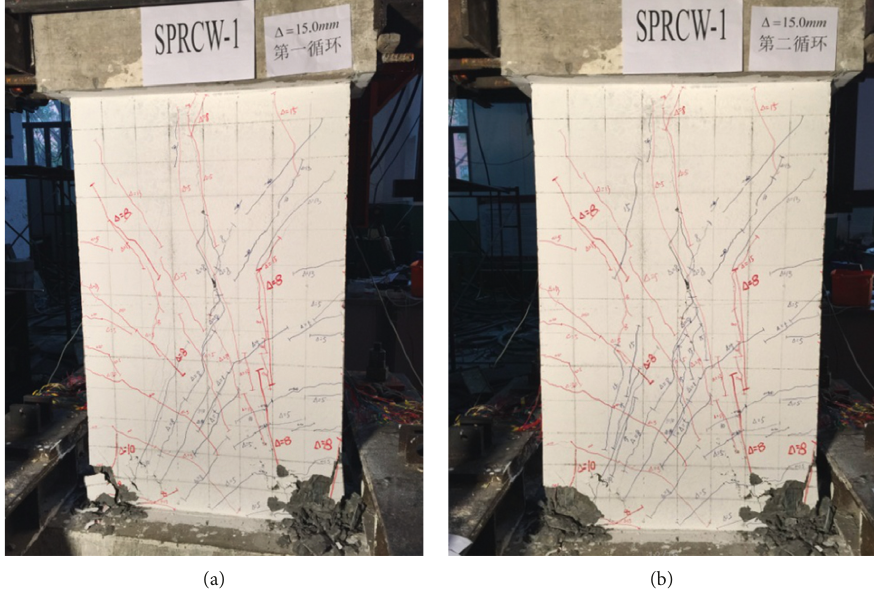
Figure 8: Diagram of cracks in the Δ � 15mm displacement cycle. (a) First cycle. (b) Second cycle.